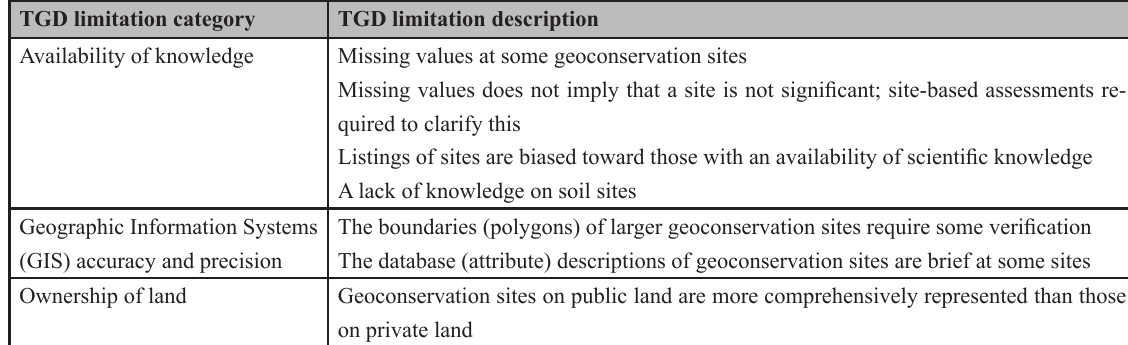
Table 1. The limitations and prospective refinements to be made to the Tasmanian Geoconservation Database (DPIPWE